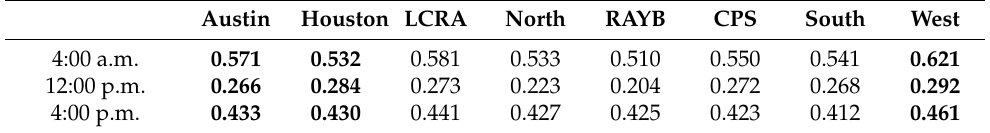
Table 3. Coefficients for the Latent Factor f t .